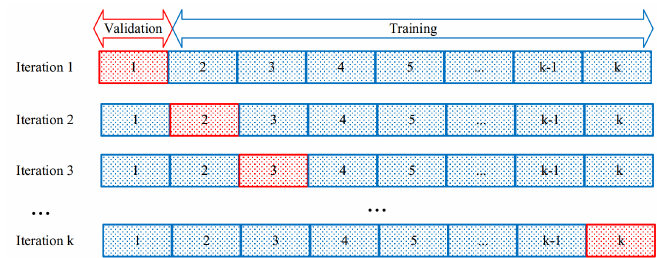
Figure 5. K -Fold